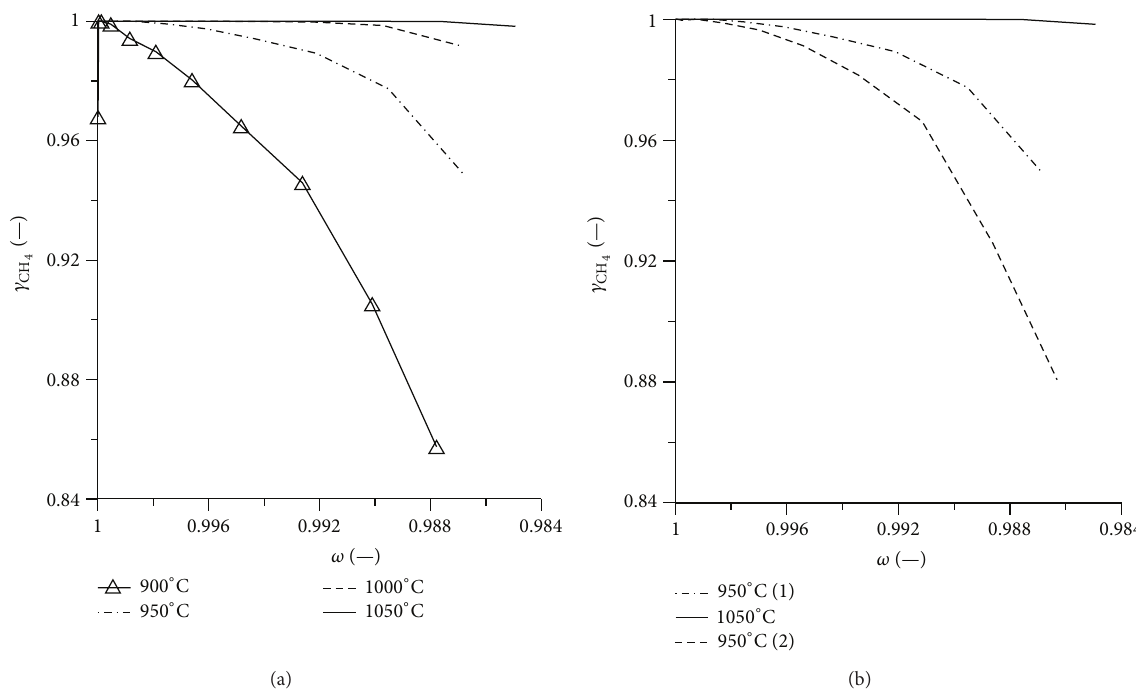
Figure 9: The methane yield as a function of solids conversion for 20 s reduction of 5.6% MgO 1300 oxygen carrier; (a) methane yield versus solid conversion for different temperatures and (b) the comparison of methane conversions at 950 ∘ C before and after 1050 ∘ C cycles. Data obtained from the second cycle is presented.